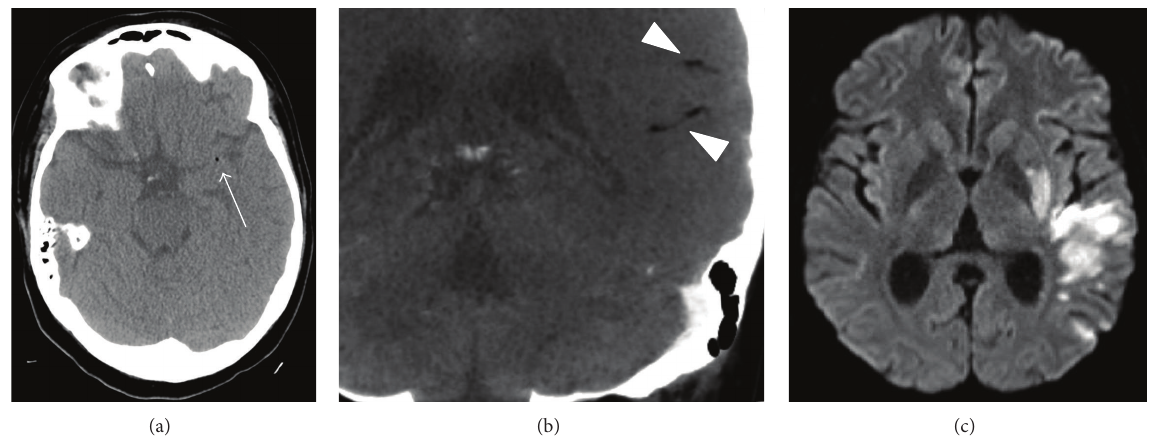
Figure 1: Air emboli on CT (a), CTA (b), and infarction on DWI sequence of MRI